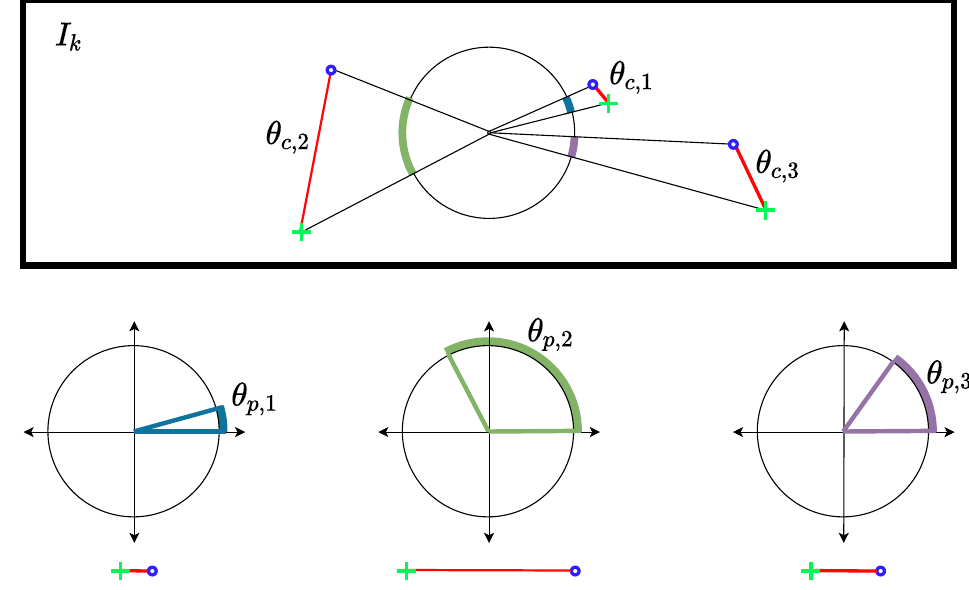
Figure 4. Visual illustration of θ c and θ p for three different feature pairs in an